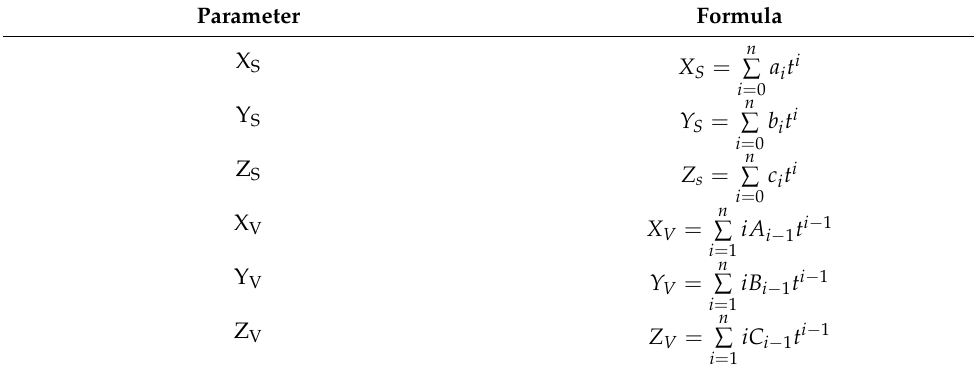
Table 2. Parameters for track data.